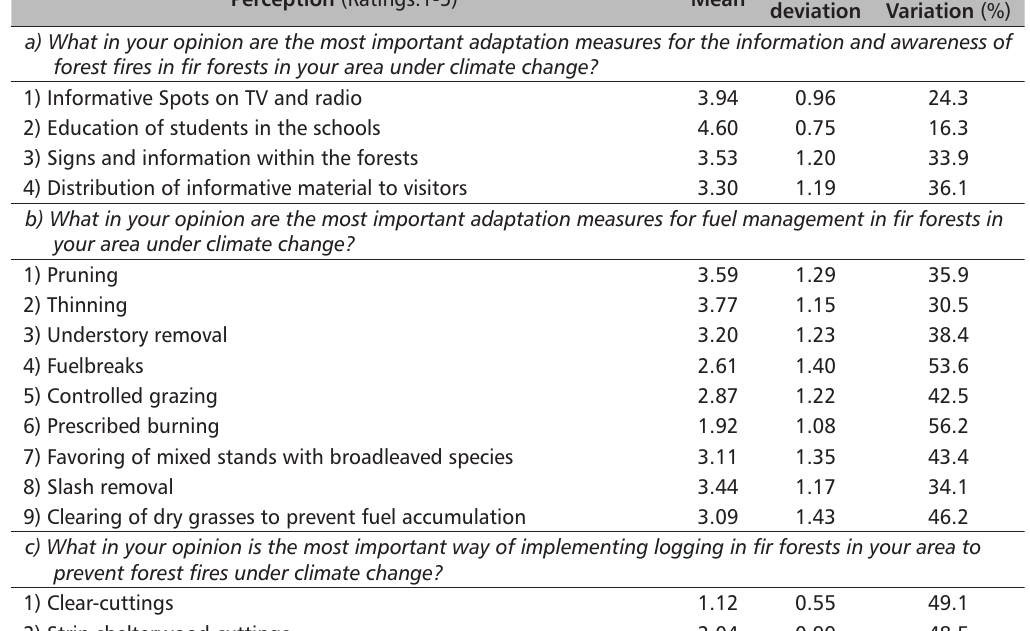
TABLE 4. Perspectives of specific prevention measures for adaptation of fir forests to fires under climate change Perception (Ratings:1-5) Mean